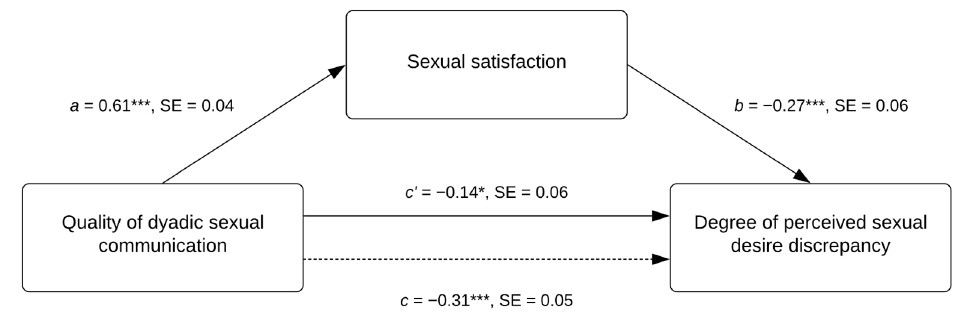
Figure 1. Graphical representation of the results from the mediation model. Please note that the reported estimates were obtained by controlling for the covariates of gender, age, sexual orientation, relationship duration, having a child/children, desire to have a child/children, and social desirability bias. The estimates correspond to standardized effects. The dashed arrow indicates the total effect. * p < 0.05; *** p < 0.001.